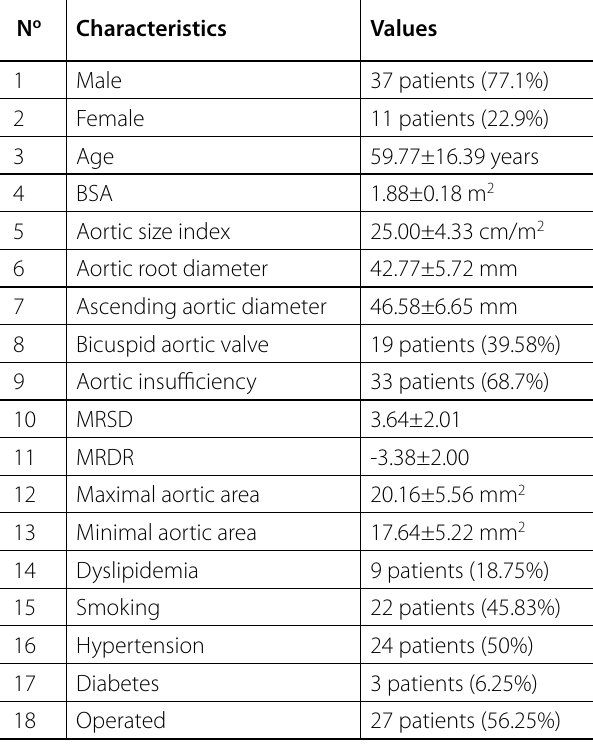
Table 1 . Characteristics of the 48 patients enrolled in this study.